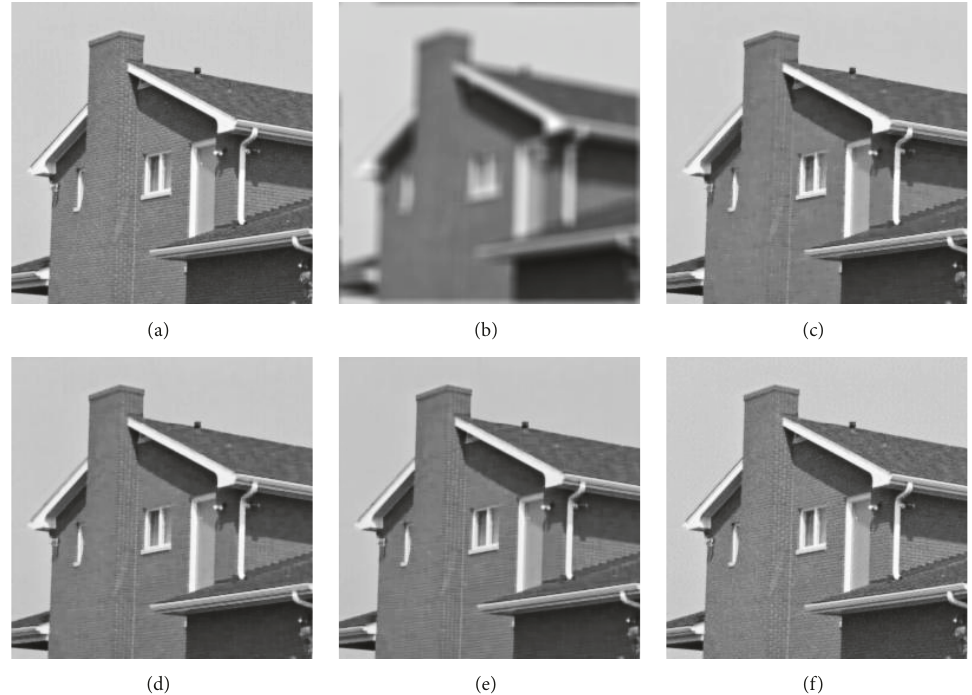
Figure5:RestorationresultsoftheHouseimagewithaverageblurkernel.(a)Originalimage;(b)blurredandnoisyimage;(c)imagerecovered by FTVd; (d) image recovered by TGV; (e) image recovered by TVframe; (f) image recovered by TGVframe.